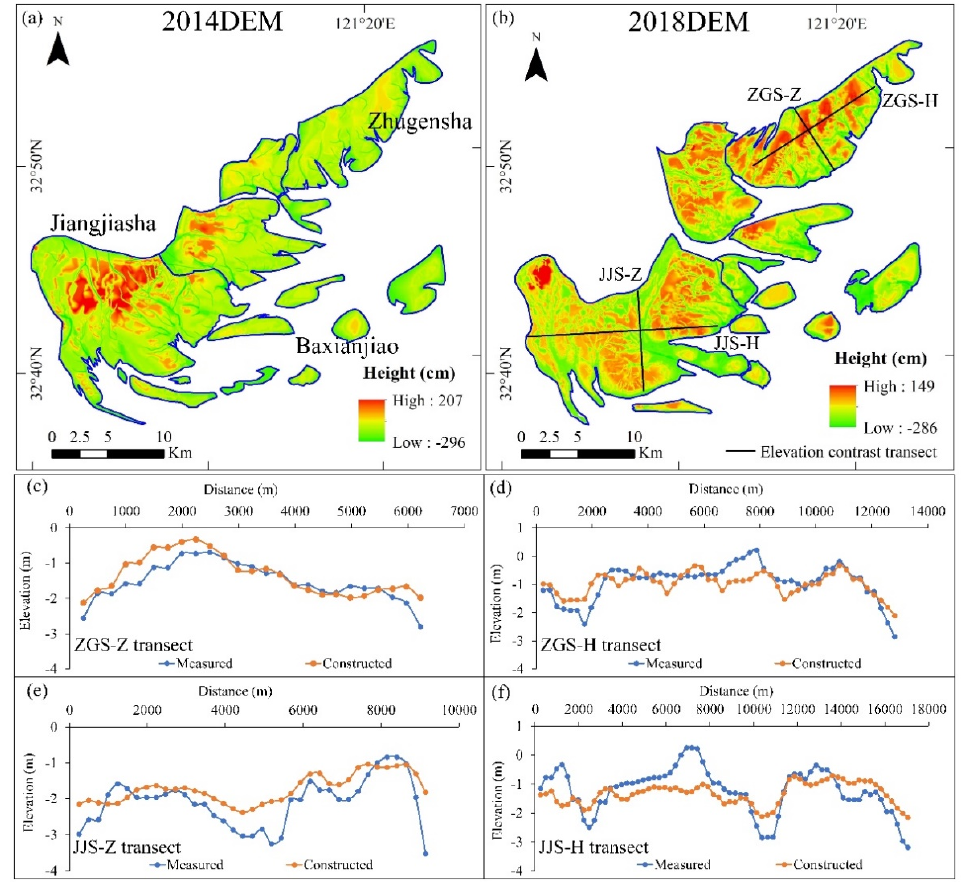
Figure 7. DEM accuracy analysis. ( a , b ) are the plain view of Liangsha OIS DEM. ( c – f ) compare measured and constructed DEM elevations along transects ZGS-Z, ZGS-H, JJS-Z, and JJS-H for the year 2018.